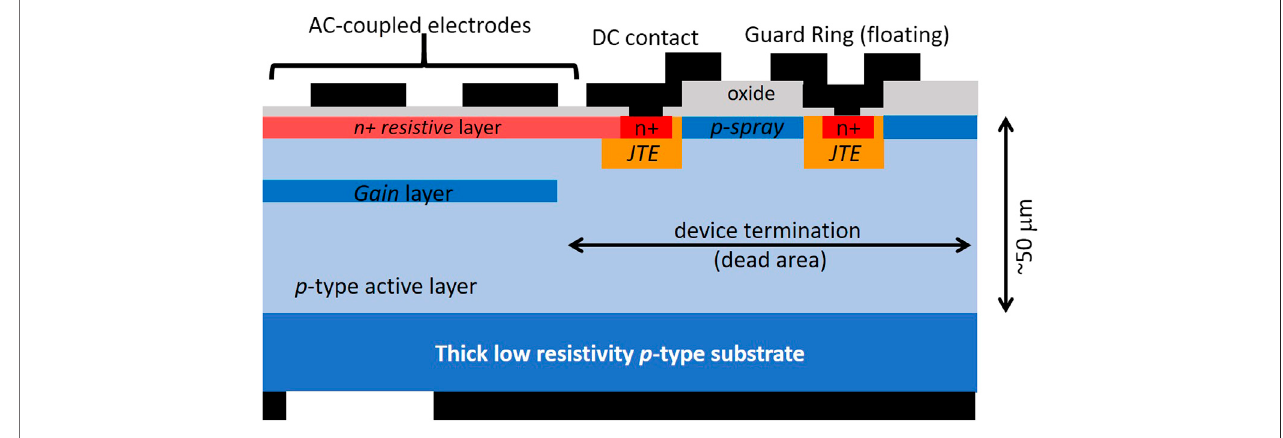
FIGURE 10 | Simpli fi ed cross-section of an AC-coupled LGAD, not to scale.